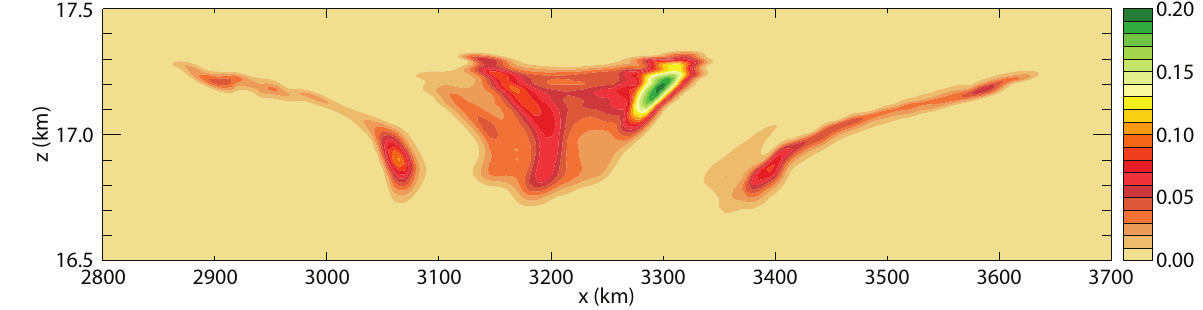
Fig. 5. The radiative heating rate (Kd − 1 ) in a cloud simulation using the cubic scheme at 50-bin-resolution. The scale is compressed in the horizontal.